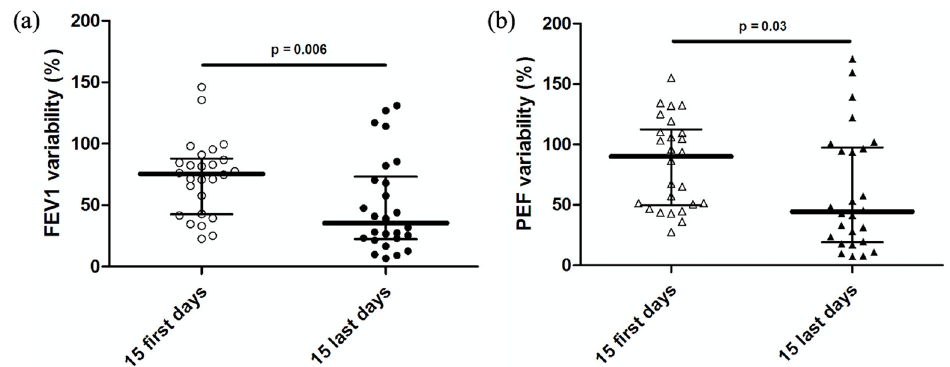
Figure 9. ( a ) FEV1 variability in the first 15 days and last 15 days of the 3-month follow-up. The vertical line ranges from the first quartile to the third quartile. The horizontal line in the middle represents the median. Each dot represents one patient. ( b ) PEF variability in the first 15 days and last 15 days of the 3-month follow-up. The vertical line ranges from the first quartile to the third quartile. The horizontal line in the middle represents the median. Each triangle represents one patient.